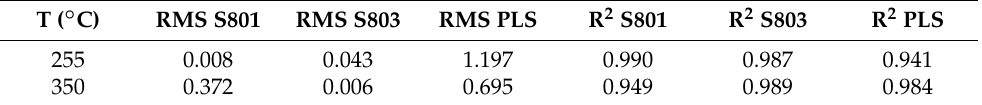
Table 4. Comparison of NO 2 -resistive gas sensors based in nanostructured MOX. Sensitive Layer